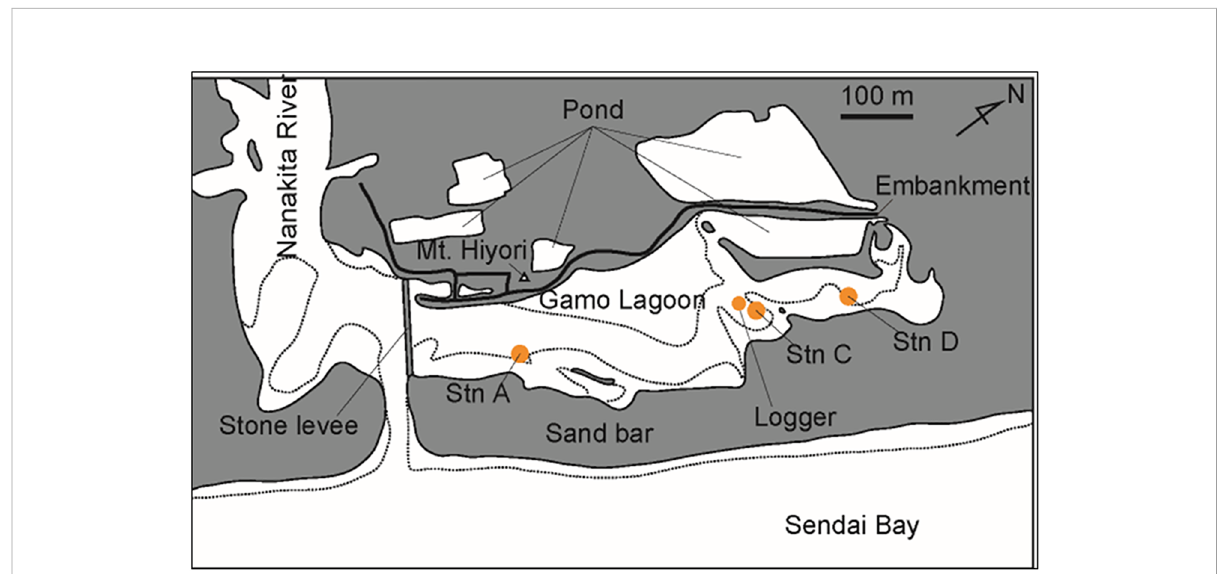
FIGURE 1 Gamo Lagoon. The bold line shows the location of Gamo Lagoon. Dashed lines show shorelines at low